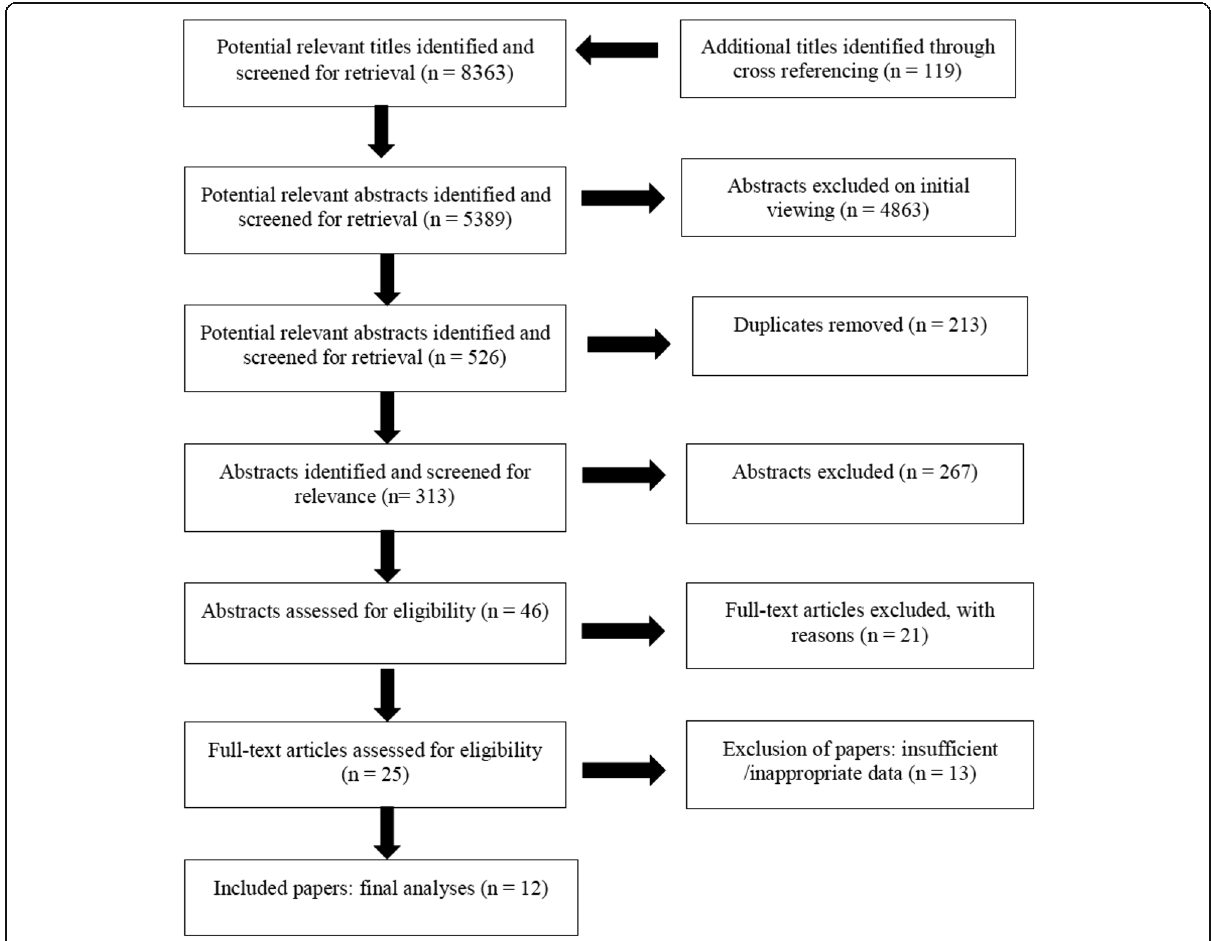
Fig. 1 The flow of journal articles through the systematic review